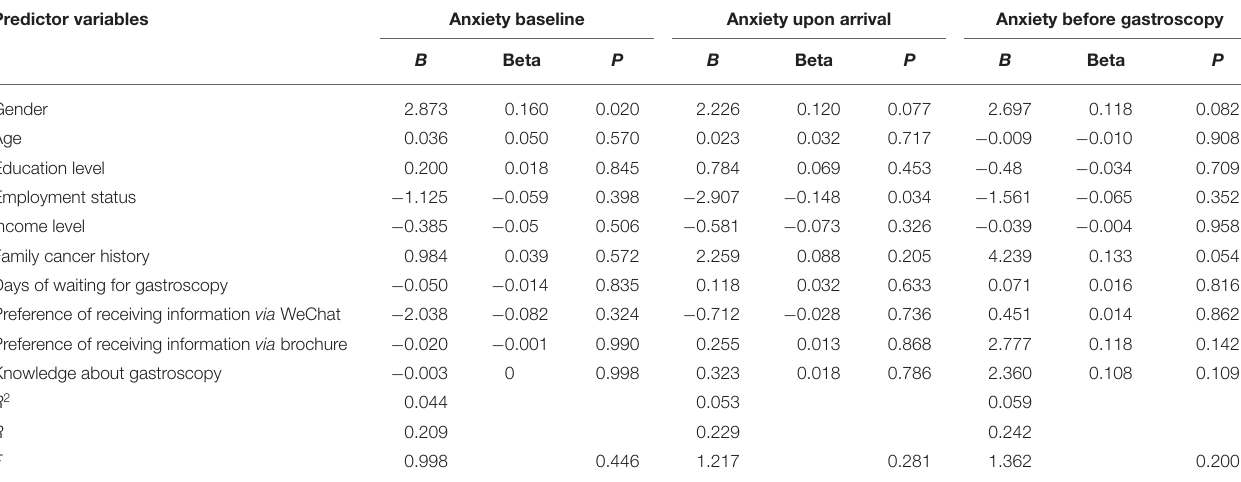
TABLE 3 | Predictors of anxiety level of patients undergoing gastroscopy at three different stages. Predictor